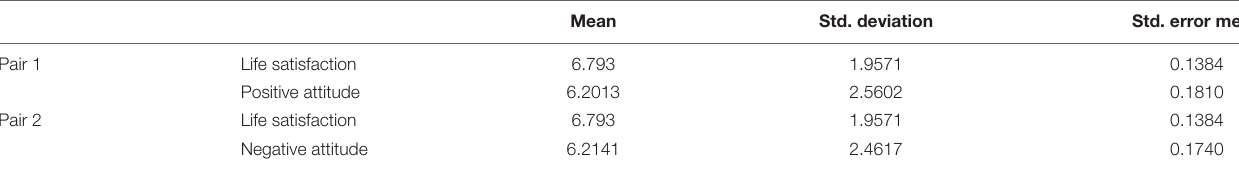
TABLE 6 | Descriptive statistics (Section 3: Life satisfaction and attitudes toward COVID-19). Mean Std. deviation Std. error mean